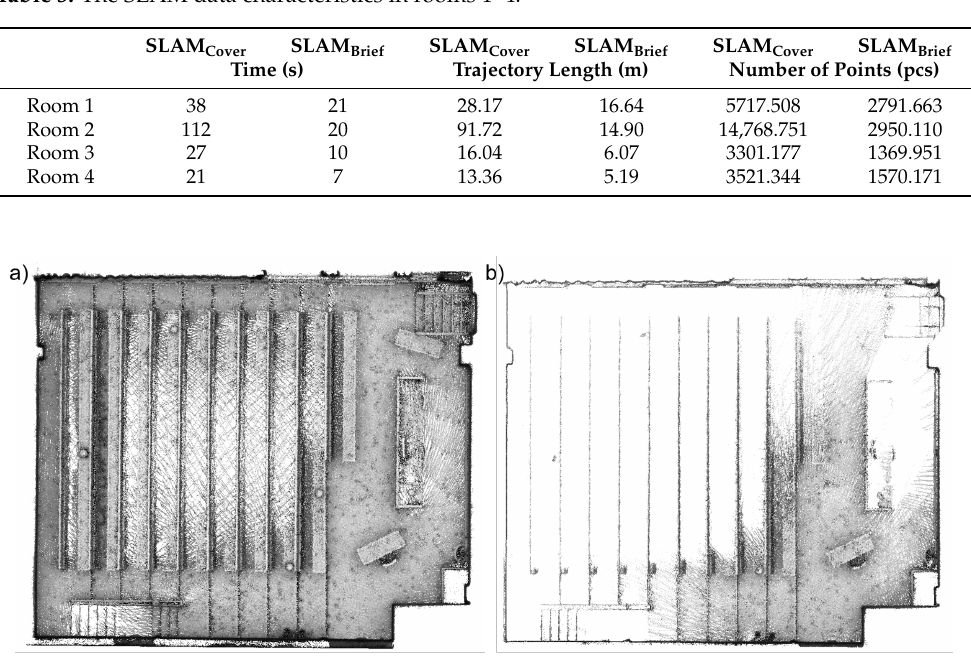
Figure 6. The data coverage in Room 2 with the SLAM LS: ( a ) the SLAM Cover path ( b ) the SLAM Brief